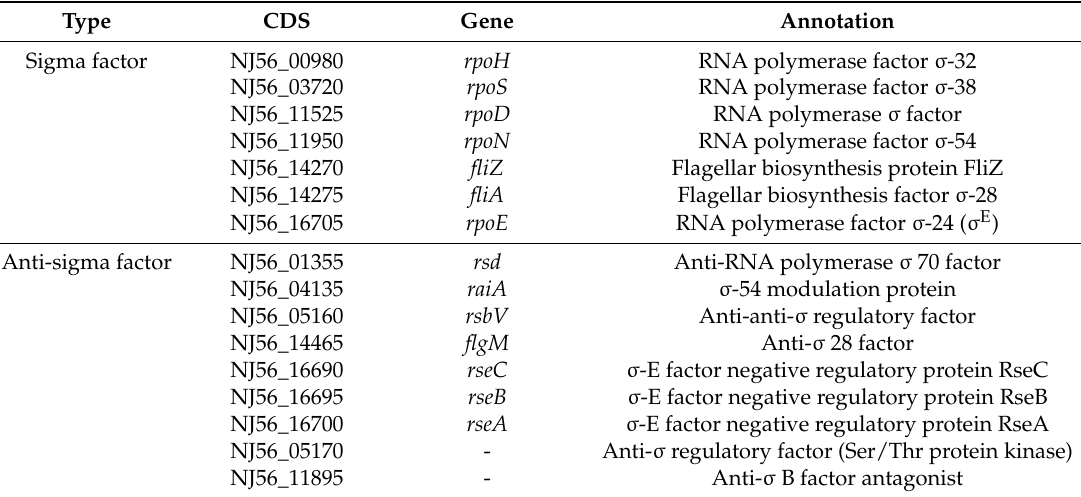
Table 4. Sigma factors and anti-sigma factors in